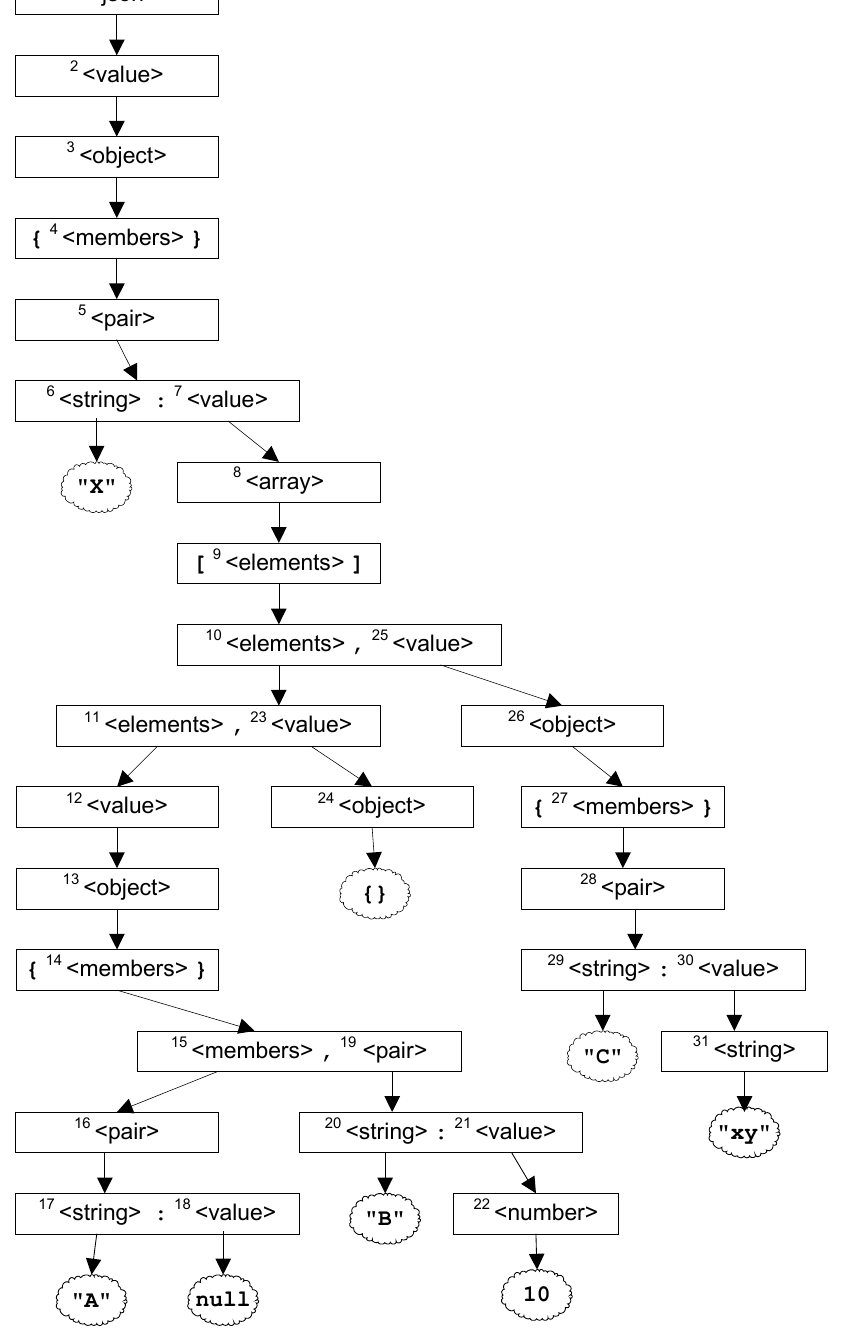
Figure 5. The syntax tree corresponding to the JSON instance (3).